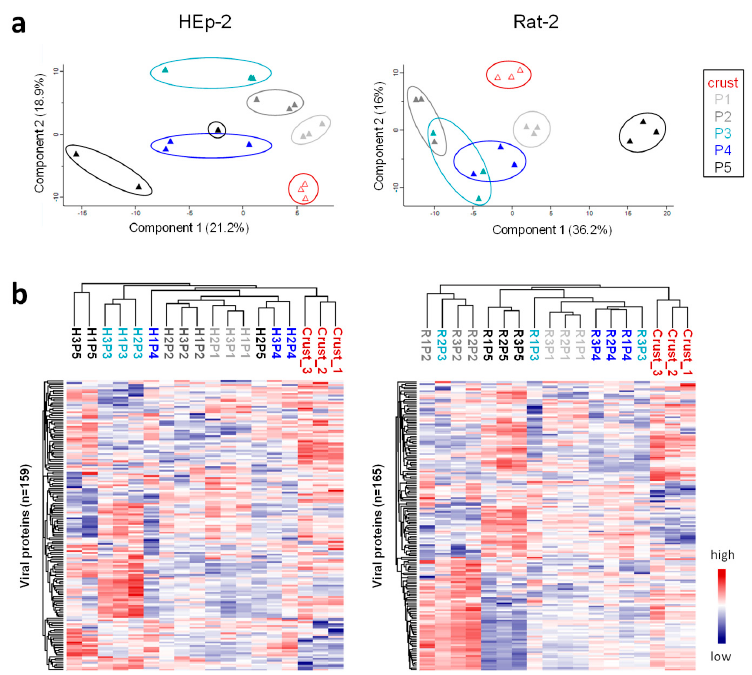
Figure 3. Principal component analysis and hierarchical clustering of CPXV IMV proteins reveal proteomic differences among passages. Normalized label-free quantification (LFQ) intensities of virus proteins without missing values were used for ( a ) principal component analysis prior to z-score normalization and ( b ) hierarchical clustering after z-score normalization.